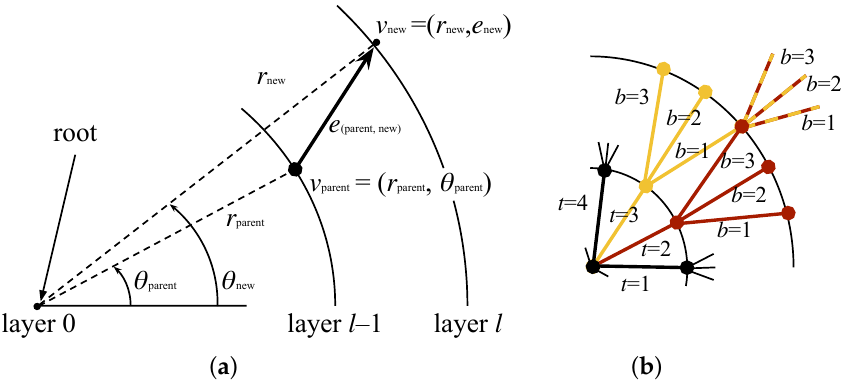
Figure 3. ( a ) Construction of the lattice adds vertices in layers around the sensor origin. Each new vertex ( v new ) is added according to its parent vertex ( v parent ). This process is executed recursively starting from the root node, where trunks t = 1,2, . . . , N T are added connecting it to the first layer of the lattice. ( b ) For each new layer, the leaf nodes are subdivided in branches b = 1,2, . . . , N B . Notice that, during this process, sub-trees are created with coincident spatial representation for some of their vertices, as exemplified in red and yellow.